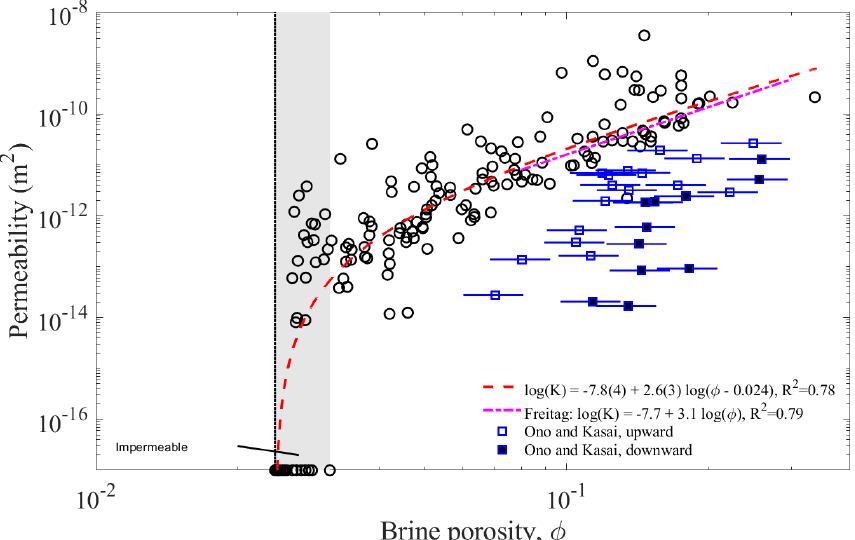
Figure 12. Relationship of simulated vertical permeability K and φ − φ c as shown in Fig. 7 as a dashed red curve, here compared to two earlier investigations. As the measurements from Freitag (1999) are only available in terms of φ cen , we plot the least-squares fit from Freitag (cyan curve, numbers given in the legend). The data points from Ono and Kasai (1985) represent downward and upward permeation of brine through the ice; see text for more